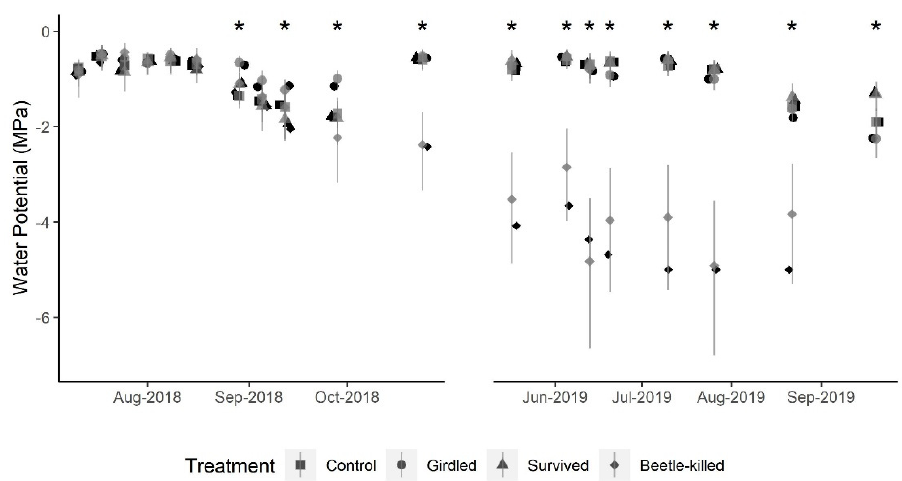
Figure 4. During the 2018 growing season, significant differences in mean water potential (WP) in September may be associate with site variations while those after October, when a rain event occurred, associated with the decline of Beetle-Killed treatment trees. In 2019, Beetle-Killed tree WP was significantly (*) more negative than in all other treatment groups. Bars are 95% confidence intervals around the model estimated means (gray). Observed means are in black. Table 2. Significant ( p -value < 0.05) pairwise differences in weekly water potential between treatments. Absolute Range Contrast